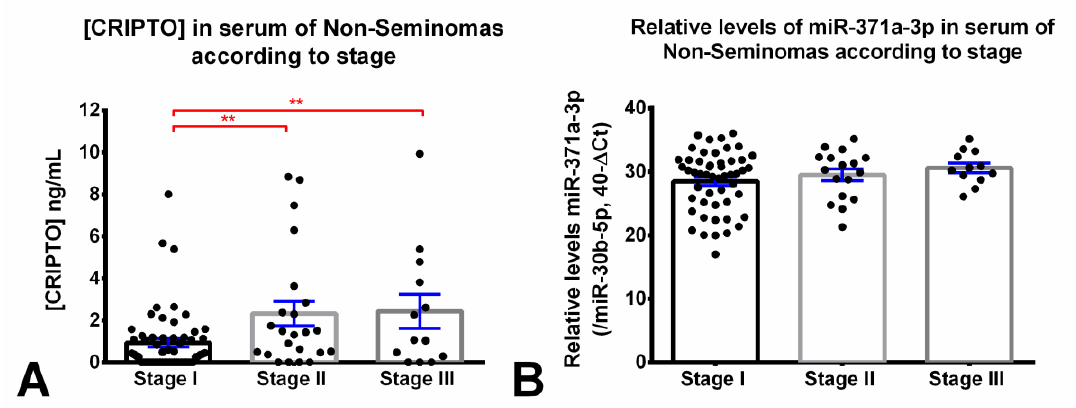
Figure 2. CRIPTO concentration and miR-371a-3p relative levels in the non-seminoma serum cohort, according to disease stage. CRIPTO concentration (ng/mL) assessed by ELISA ( A , Kruskal–Wallis test p -value = 0.0121 and 0.4250) and relative levels of miR-371a-3p assessed by RT-qPCR ( B ) in non-seminoma patients with stage I, II, and III disease. Error bars represent mean ± S.E.M. Relative levels of miR-371a-3p were normalized with miR-30b-5p and plotted in the 40-ΔCt format. ** p < 0.01.